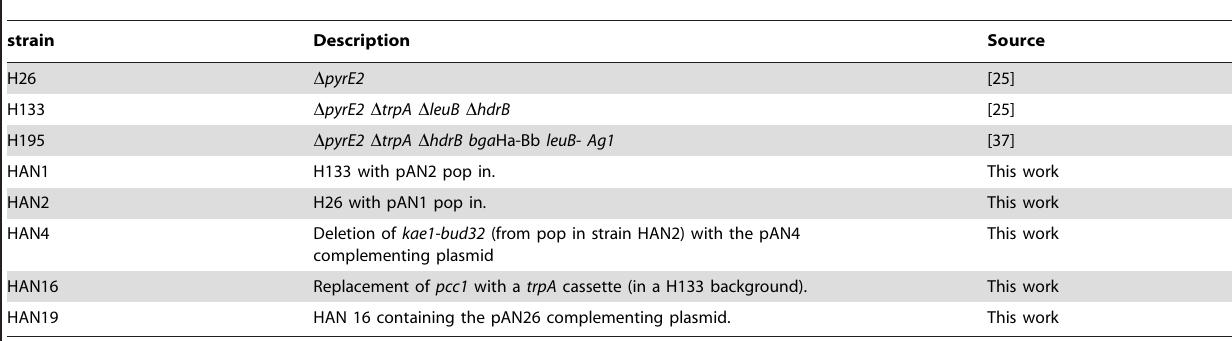
Table 1. Strains used in this